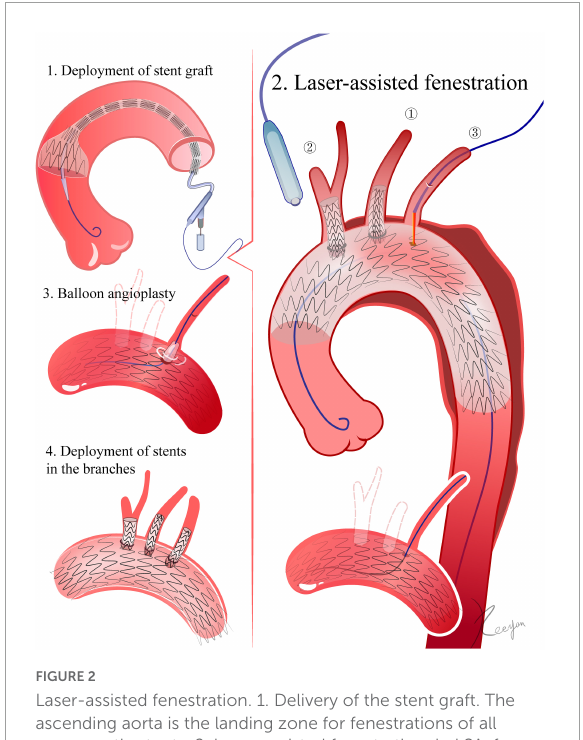
FIGURE1 Needle fenestration. 1. Delivery of the stent graft. The ascending aorta is the landing zone for fenestrations of all super-aortic stents. 2. Needle fenestrations. In LSA, for example, a 6F angle-adjustable sheath is introduced retrogradely until its tip reaches the aortic stent graft. Once the sheath reaches the ideal place, a flexible needle is employed to create the fenestration in the aortic stent graft. A 0.018-inch guidewire is advanced through the needle’s aperture and into the ascending aorta after the puncture. 3. The initial aperture is then expanded by balloon angioplasty. 4. Deployment of stents in the branches.